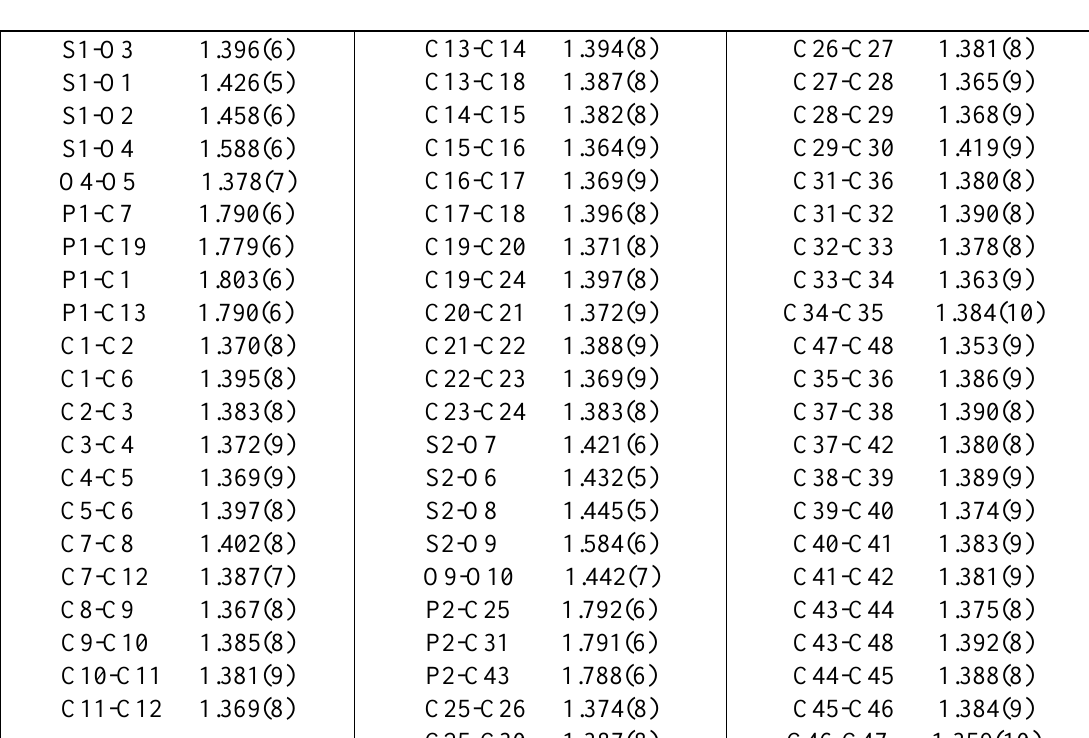
Table 2 . Bond lengths [Å] for ( 4